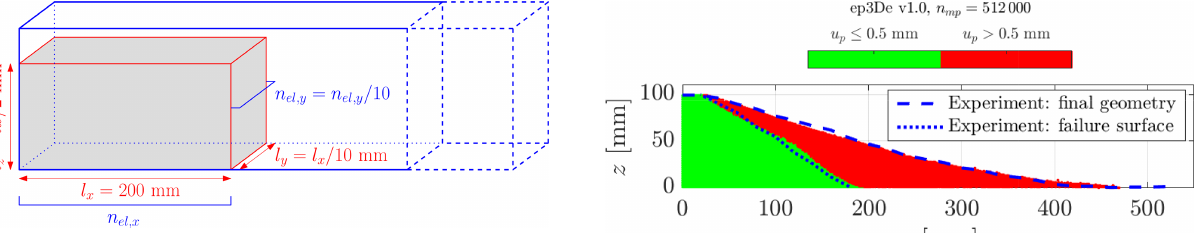
Figure 5. Initial configuration for the granular collapse numerical model. The blue surrounding frame depicts the computational do- main (i.e. the background Eulerian mesh), and the red volume is the granular material, which is discretized by 8 material points. The total number of background elements n el depends on the number of elements in the x direction n el ,x used to discretize the granular material.